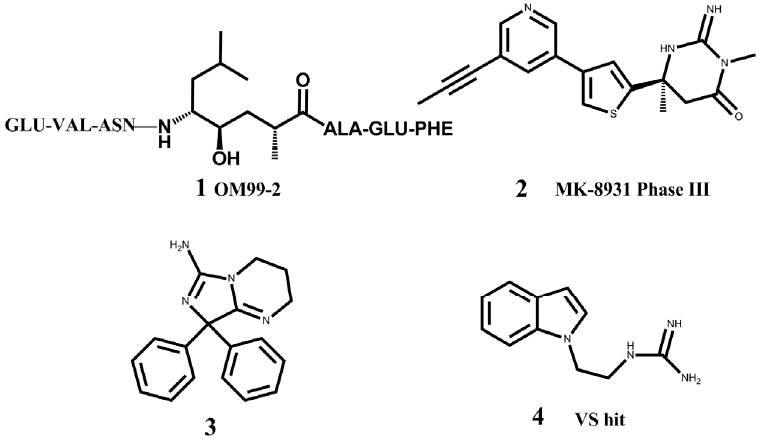
Figure 1. Representative BACE1